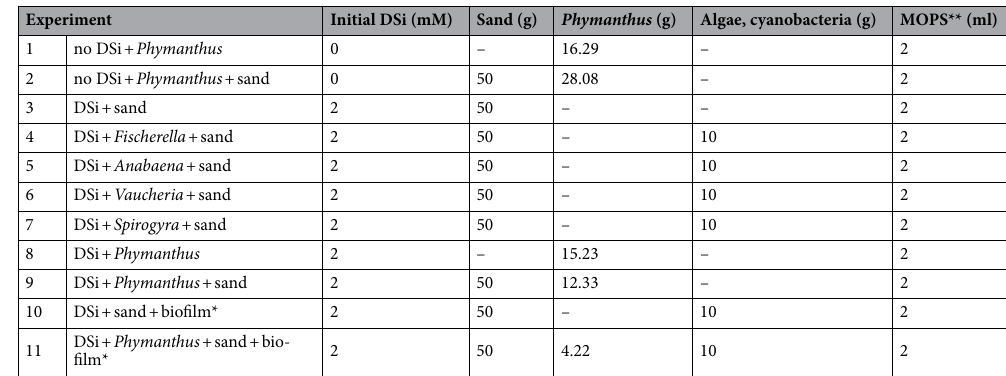
Table 1. Experimental setup. DSi dissolved silica. Noted masses of Phymanthus are for the first run of each experiment. Biofilm refers to equal proportions of Fischerella, Anabaena, Vaucheria, and Spirogyra. **3-(N-morpholino)propanesulfonic acid.